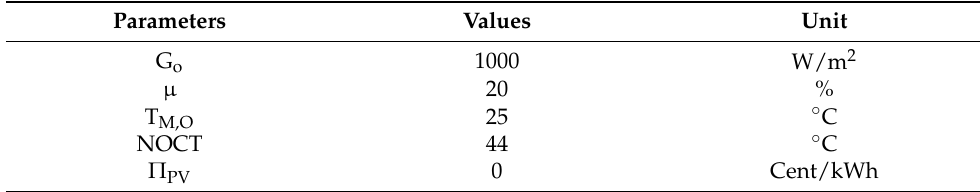
Table 2. PV panel parameters. Reproduced from [49], the (Journal of Energy storage): 2021. Parameters